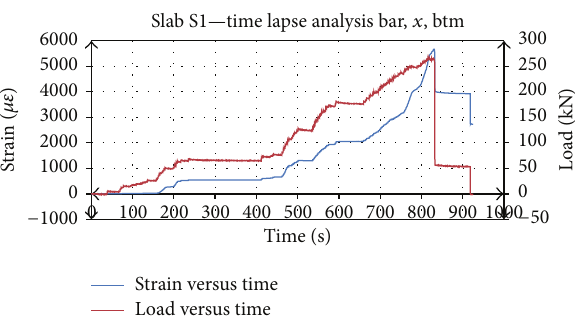
Figure 20: Tensile strength results.